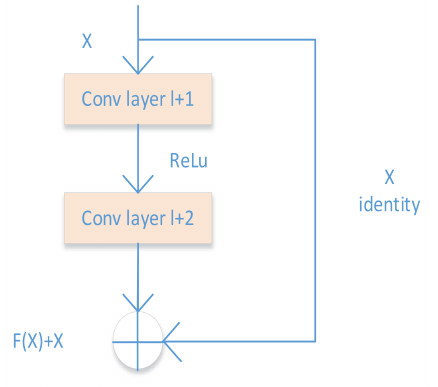
Figure 4. Skip connections with r =